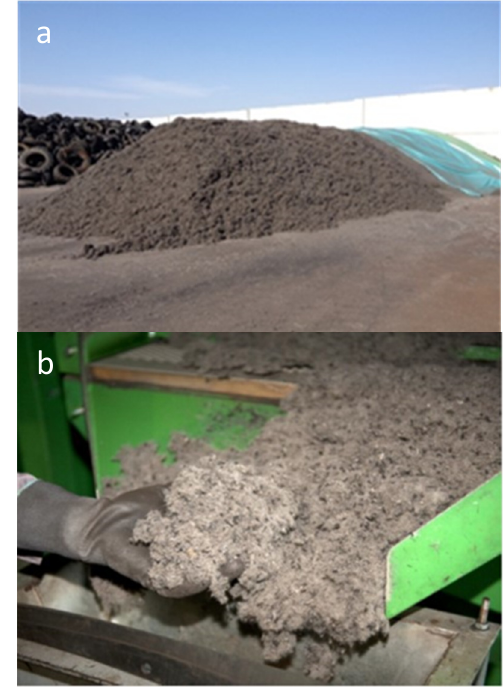
Figure 1. Recycled tire polymer fibers: a) Landfill of RTPF; b) RTPF in the process of transport to landfill.